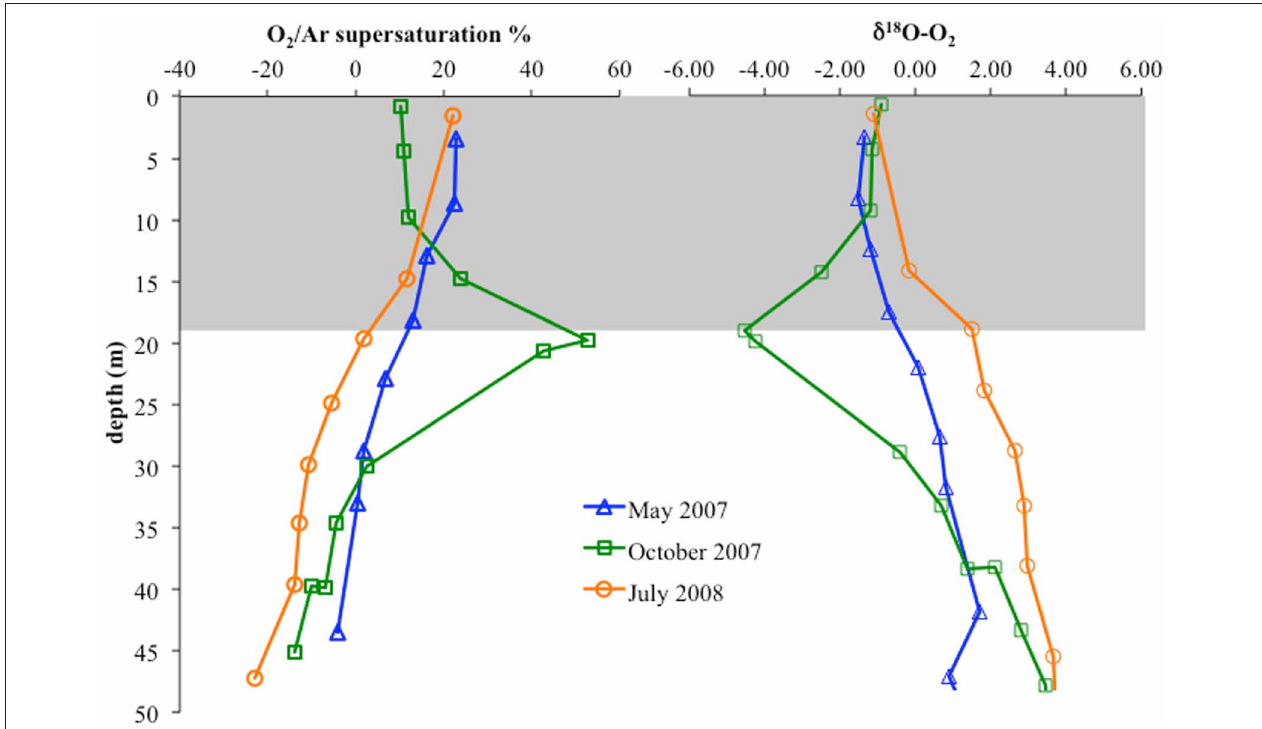
FIGURE 10 | Left: O 2 /Ar supersaturation versus depth in the upper 50m for May 2007, October 2007, and July 2008. Right: δ 18 O-O 2 versus depth. Gray box indicates average mixed layer